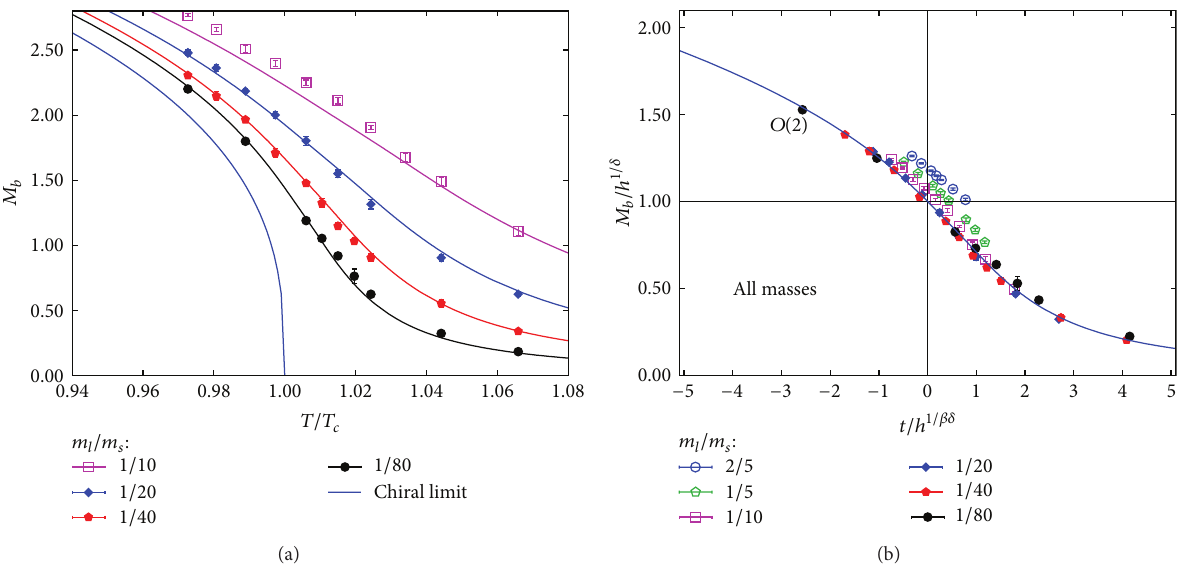
Figure 10: The interpolated data for 𝑀 𝑏 for different light quark masses are compared with the corresponding plot for an 𝑂(4) spin model in the continuum, denoted by the solid blue line (a). In (b), the scaling plots for the chiral condensate for QCD are shown to match with the universal function with 𝑂(2) symmetry for 𝑚 𝑙 /𝑚 𝑠 < 1/20 . Both the plots are for p4 staggered quarks, from